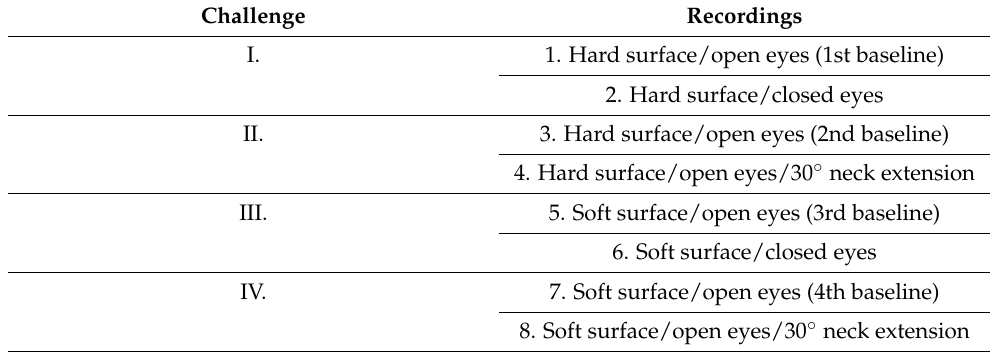
Table 1. Sensory challenges included in the study.